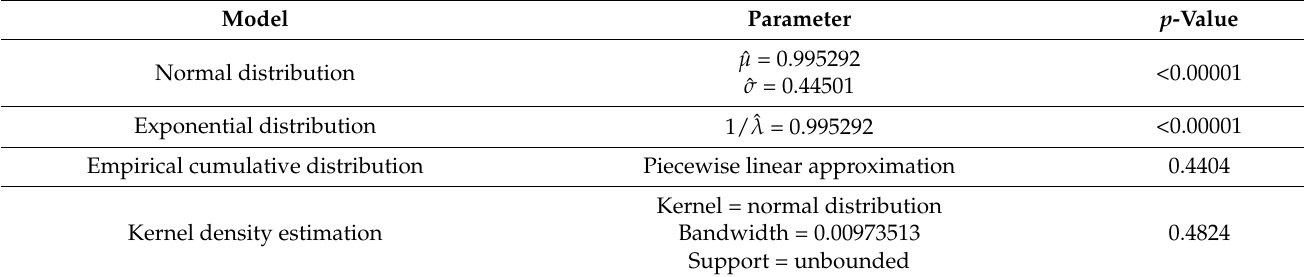
Table 5. The fitted distributions and the p -values of the two-sample Kolmogorov–Smirnov test.